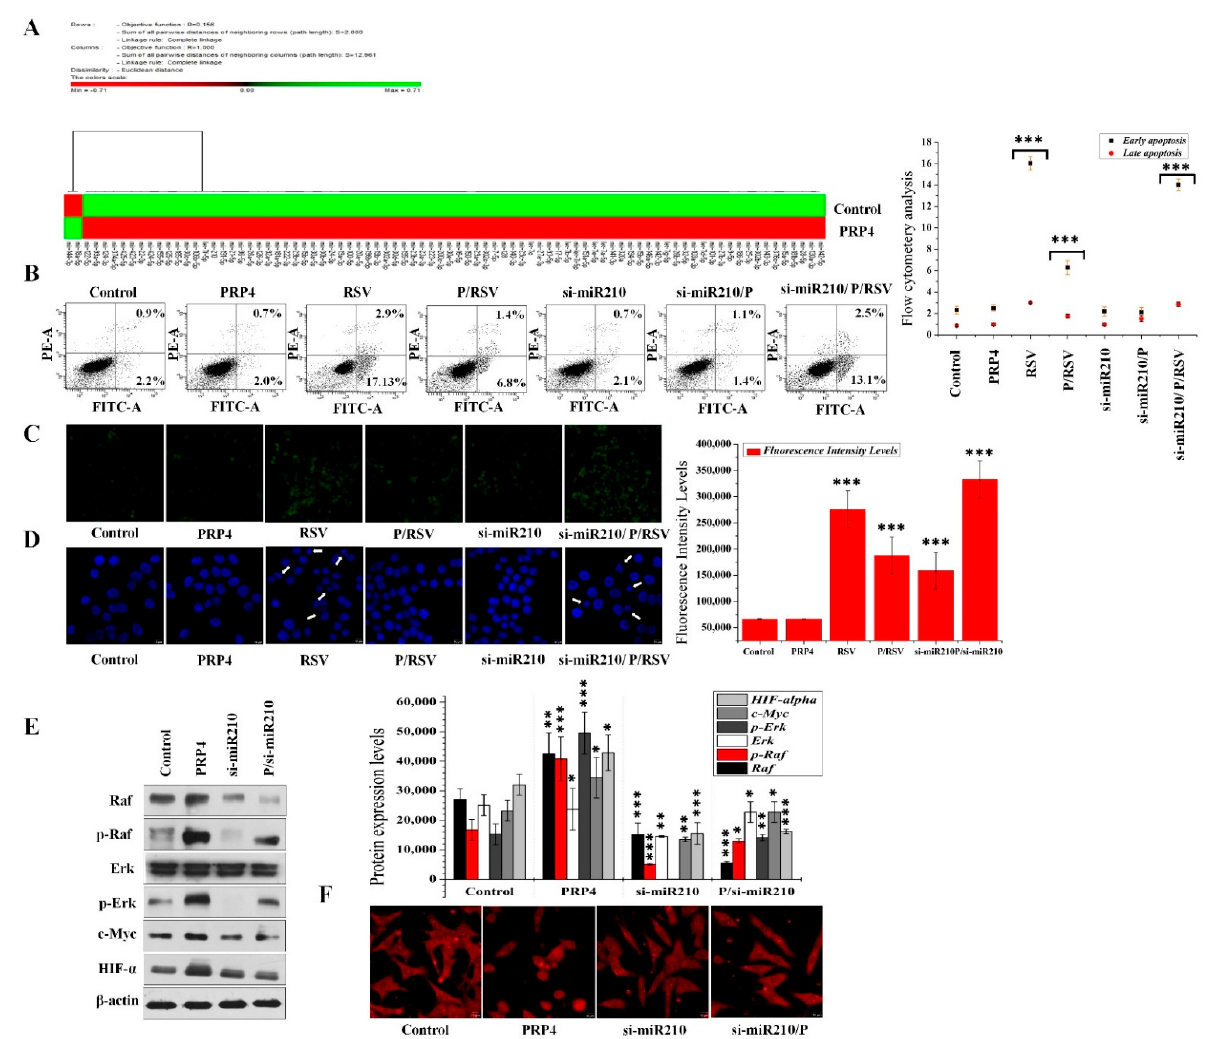
Figure 4. PRP4 induces drug resistance and modulates cell morphology by activating miR-210: ( A ) The green symbols represent miRNAs expressed at levels above the mean, the red symbols represent miRNAs expressed at levels below the mean; ( B ) the inhibitory impact of si-miR210 on PRP4 activity, lower and upper right panels represent early and late apoptotic cells, respectively. si- miR210, cells transfected with LentimiRa-GFP-hsa-miR-210-3p vector; si-miR210/P, cells transfected with si-miR210 and PRP4; si-miR210/P/RSV, cells transfected with si-miR210 and PRP4 followed by treatment with resveratrol. *** p < 0.001; ( C ) HCT116 cells transfected with a PRP4 expression plasmid or si-miR210 and incubated with or without 10 µ M resveratrol (RSV) for 24 h. The cells were incubated with DCFHDA dye for 20 min to measure reactive oxygen species (ROS). Probe accumulation was measured in triplicate based on increased emission at 530 nm. ROS levels are expressed as the ratio of sample’s mean intensity to the control cells’ mean intensity. *** p < 0.001; ( D ) DAPI staining of cell nuclei, white arrowheads indicate fragmented nuclei; ( E ) Western blot analysis using antibodies (1:1000 dilution) specific for Raf, p-Raf, Erk, p-Erk, and c-Myc. HIF-1 α with actin was used as an internal control. * p < 0.05, ** p < 0.01, *** p < 0.001; ( F ) F-actin phalloidin